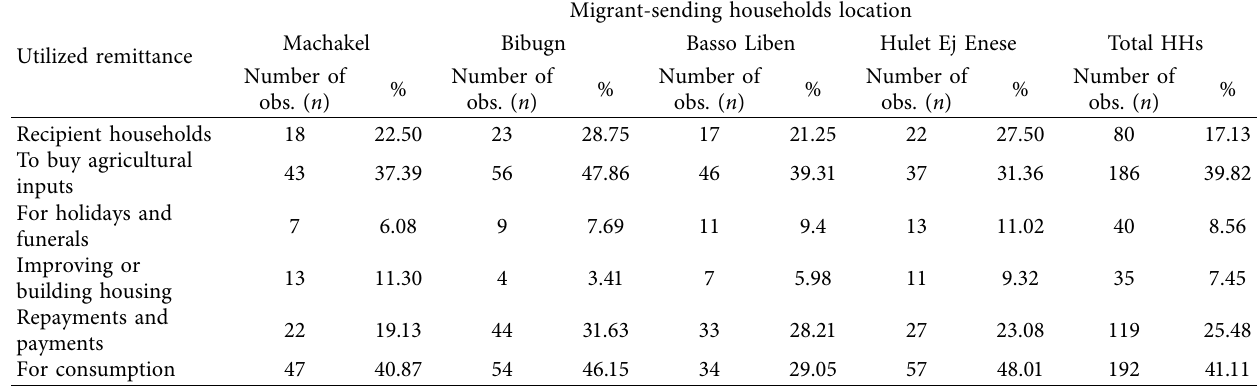
Table 2: Utilization of